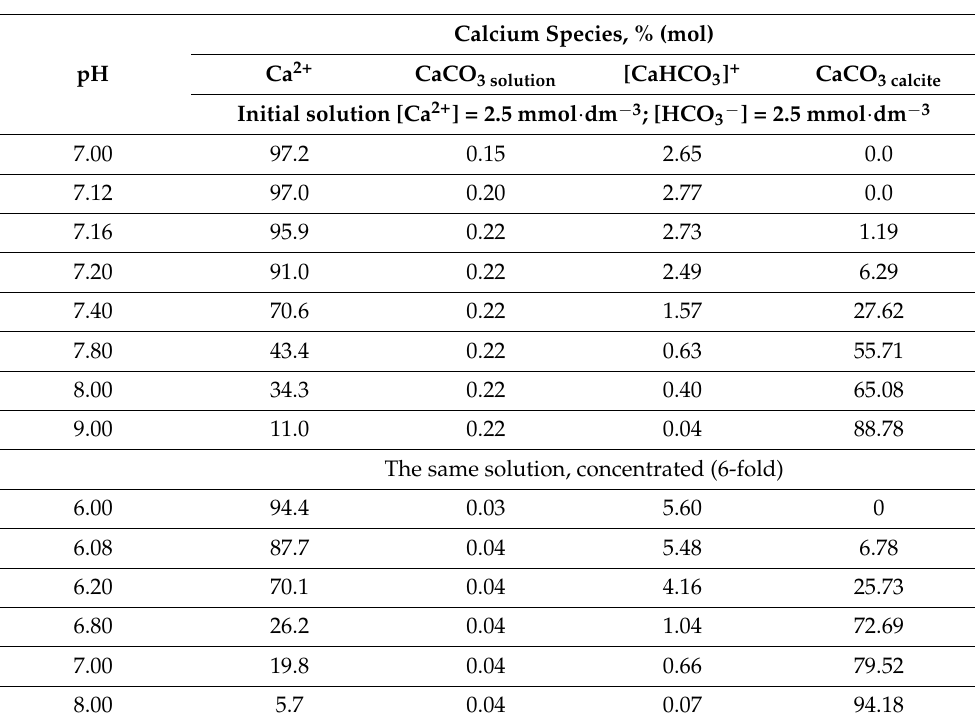
Table 1. Equilibrium constants (log K ), used for equilibrium speciations at 25 ◦ C and I = 0. Equilibrium log K (-log K sol ) Reference Ca 2+ + CO 32- (cid:29) CaCO 3 calcite 8.485 [18] Ca 2+ + CO 32- (cid:29) [CaCO 3 ] solution 3.22 [17] H + + CO 32 − (cid:29) HCO 3 − 10.34 [19] H + + HCO 3 − (cid:29) H 2 CO 3 6.36 [19] *where [H 2 CO 3 ] = [CO 2 (aq)] + [H 2 CO 3 ] Ca 2+ + HCO 3 − (cid:29) CaHCO 3+ 1.14 [20]